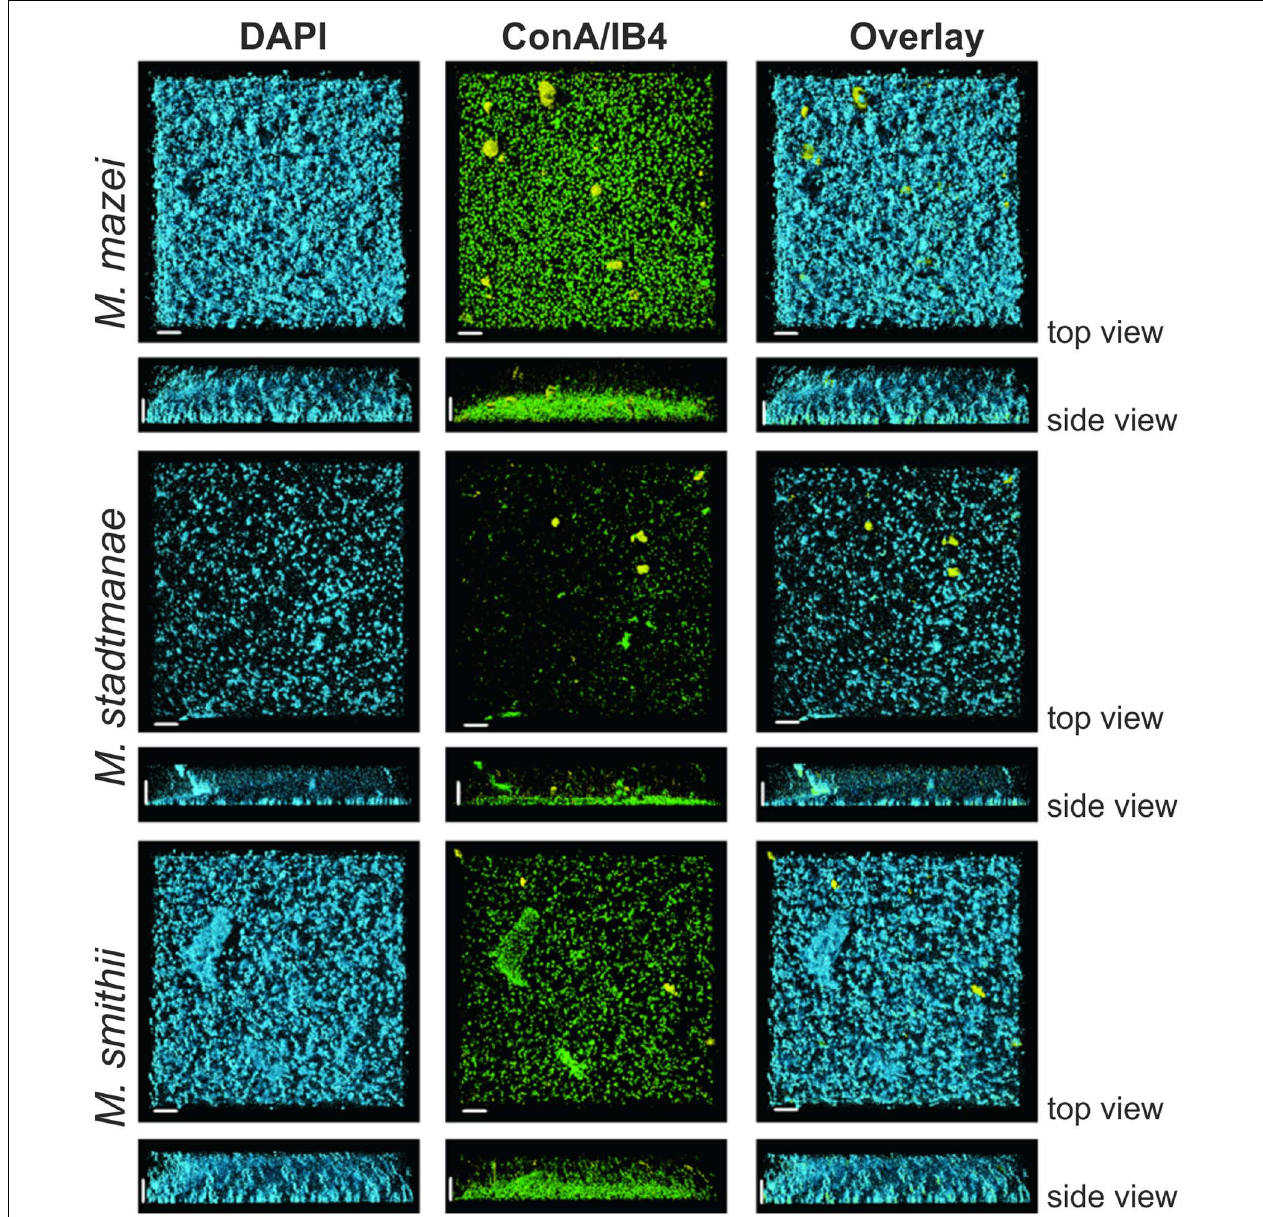
FIGURE 4 | Structures of static biofilms formed by Methanosarcina mazei , Methanosphaera stadtmanae, and Methanobrevibacter smithii . Cells were grown in 4 ml standard medium in μ -dishes TM under the respective gas atmosphere. After 72 h of growth, the biofilms were treated